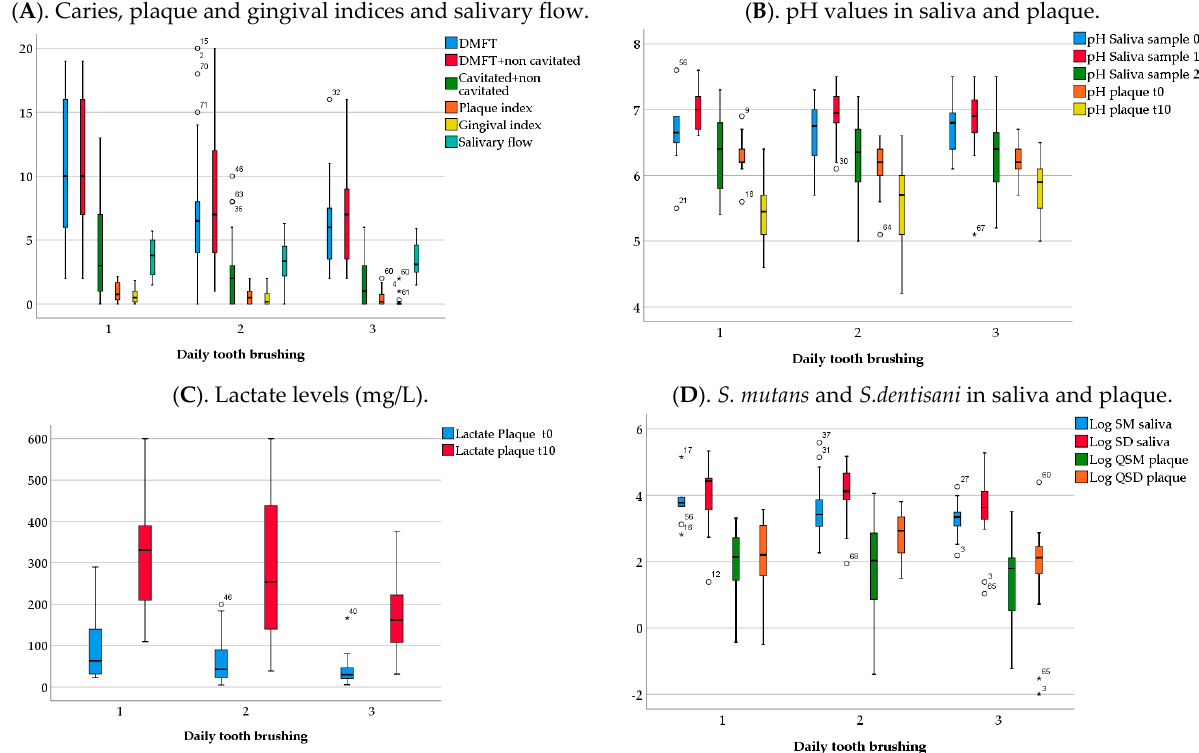
Figure 2. Clinical, biochemical and microbiological variables by daily tooth-brushing. Graphs show medians and IQR values for the different variables. ( A ) DMFT = ICDAS codes 3–6 + restoration ICDAS codes 7 and 8 + missing teeth due to caries + filled teeth due to caries. DMFT with non-cavitated lesions = DMFT + ICDAS codes 1–6 + restoration ICDAS